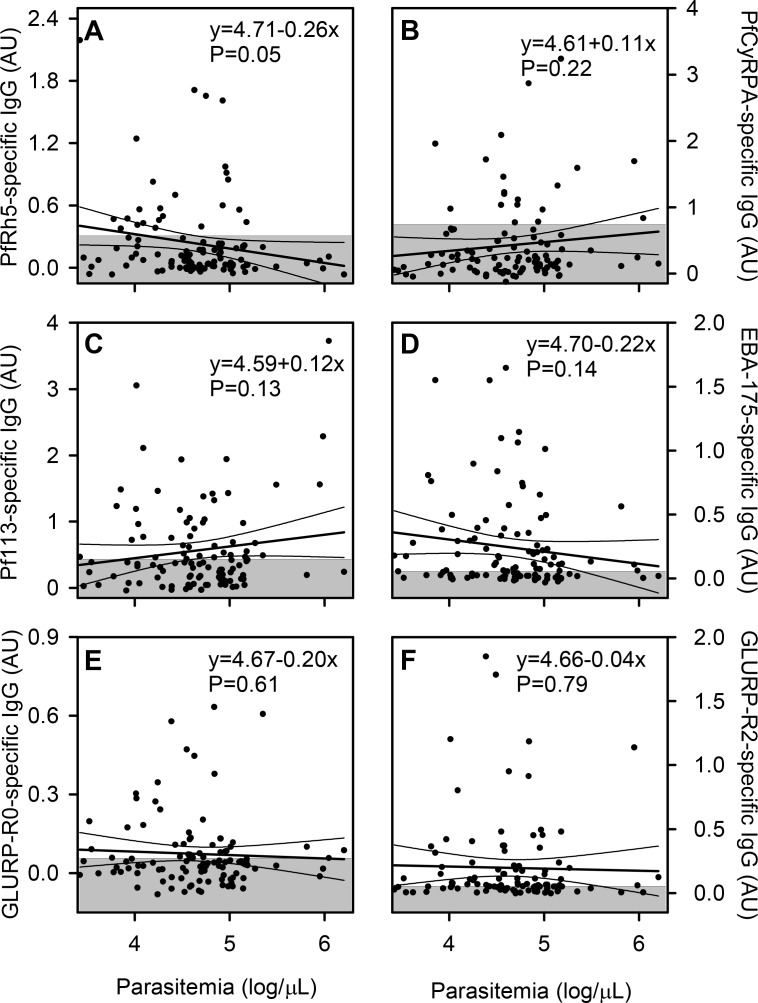
Relation between asexual P. falciparum parasitemia and merozoite-specific IgG.Correlations between parasitemia (parasites/μL) and plasma levels (AU) of IgG specific for PfRH5 (A), CyRPA (B), Pf113 (C), EBA175 (D), GLURP-R0 (E) and GLURP-R2 (F) in children with P. falciparum malaria. Data points for individual children, linear regression lines (and their 95% confidence intervals) for all the data, and negative cut-offs (shaded areas) are shown. The presented data is from one experiment.